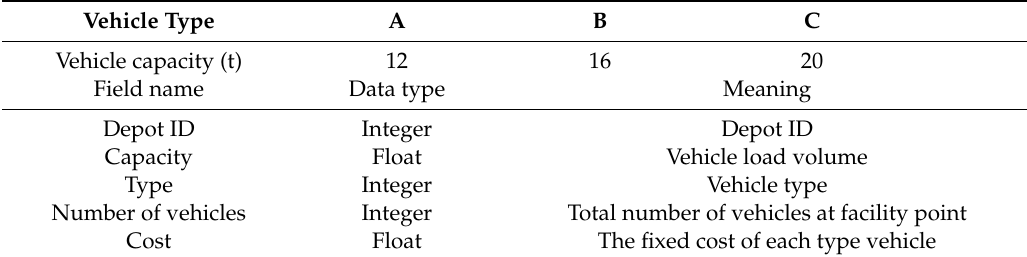
Table 3. Vehicle classification and